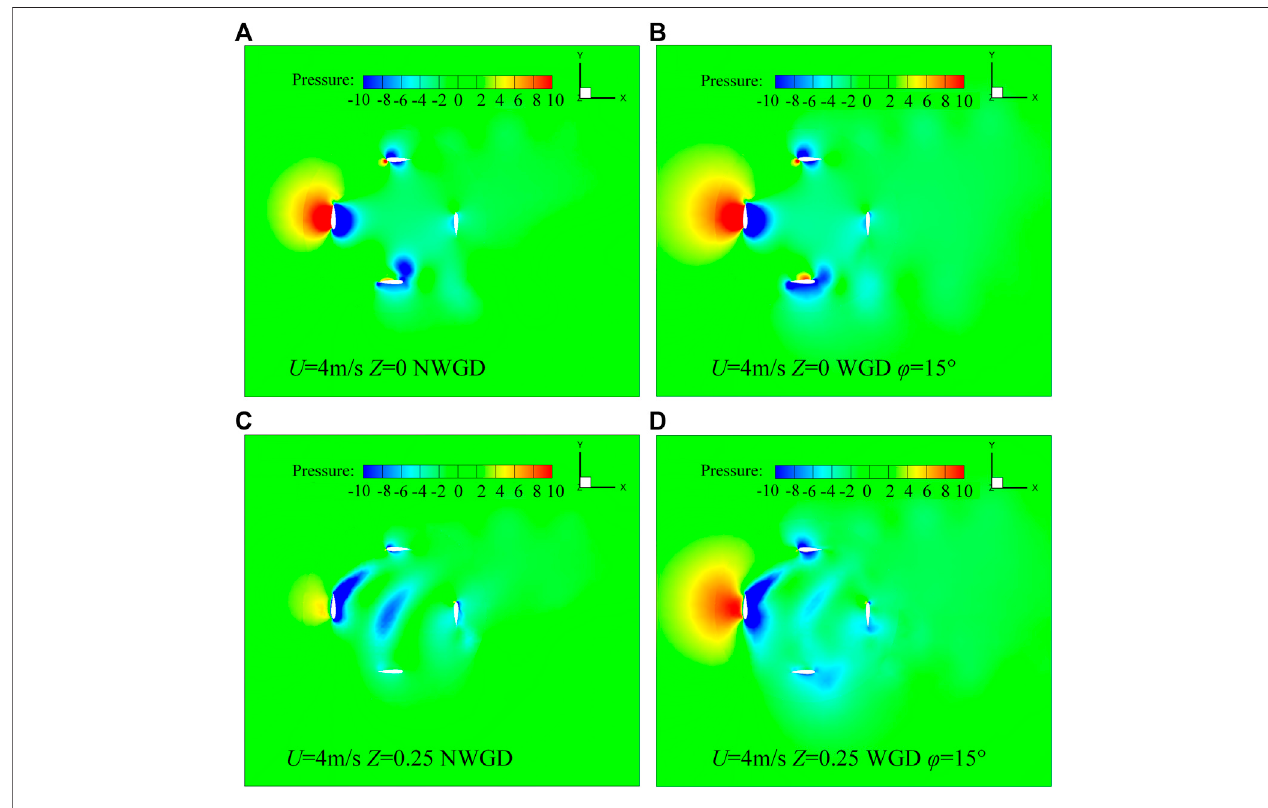
FIGURE 11 | Dynamic pressure